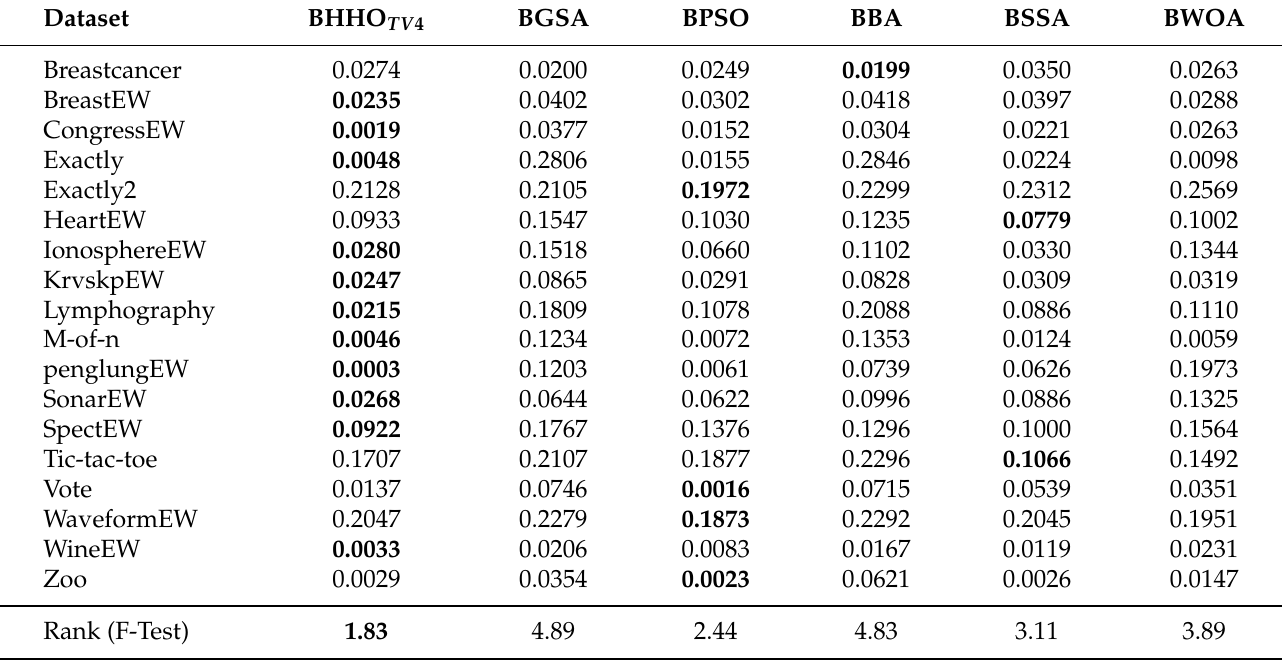
Table 11. Comparison of BHHO TV 4 versus other optimizers in terms of average fitness values.